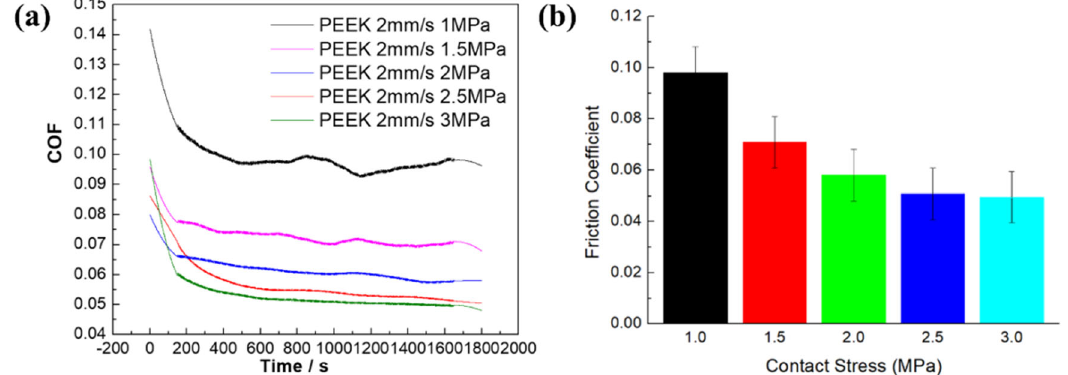
Fig. 10 The friction coef fi cient of different stresses. a Time-varying friction coef fi cient; b stable friction coef fi cient